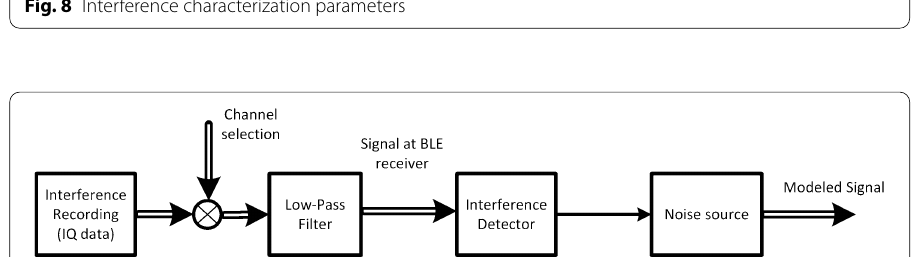
Fig. 8 Interference characterization parameters